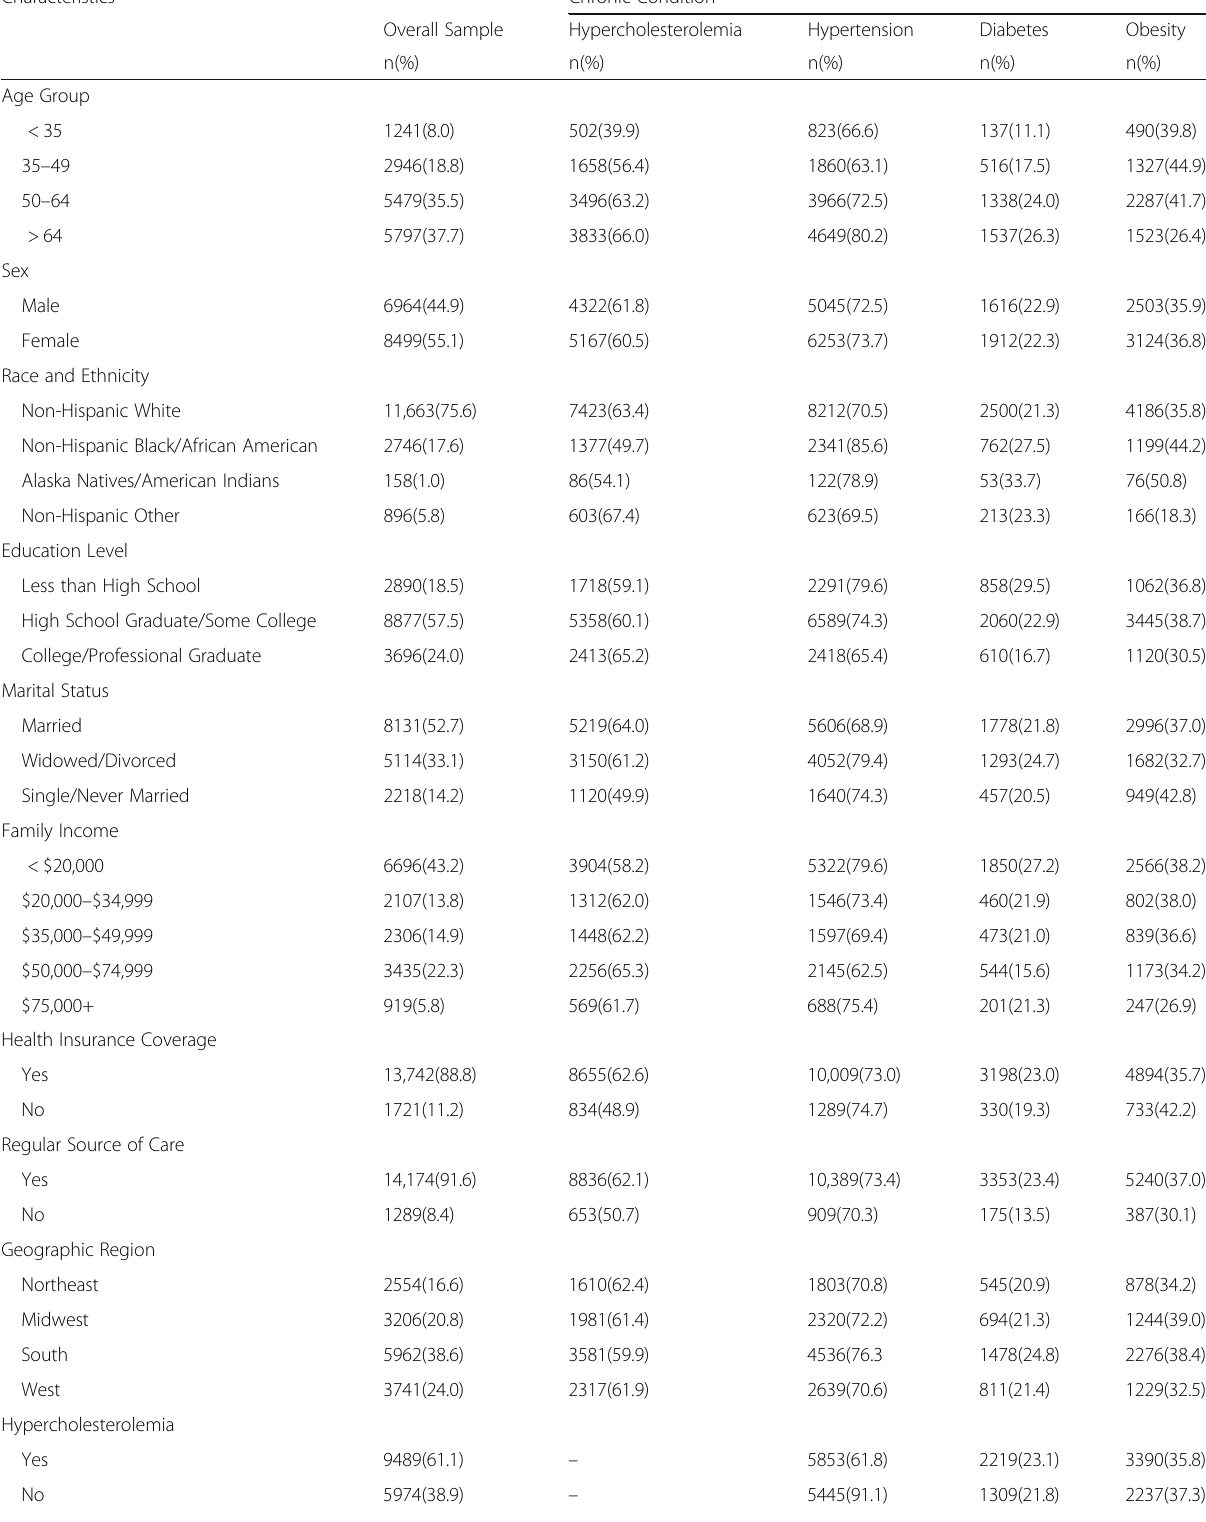
Table 1 Characteristics of the study sample and frequency of chronic conditions, national health interview survey, 2012